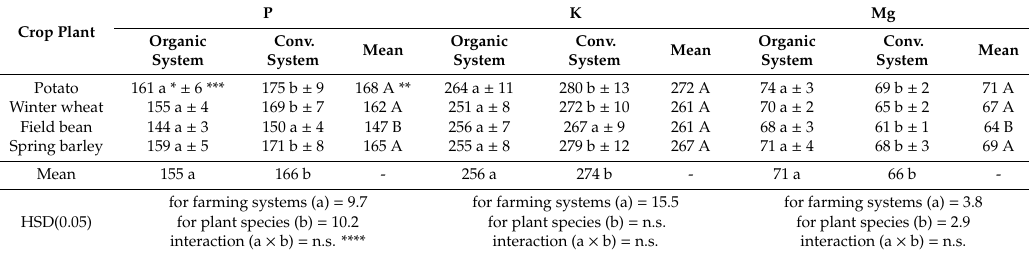
Organic Conv. System System Mean